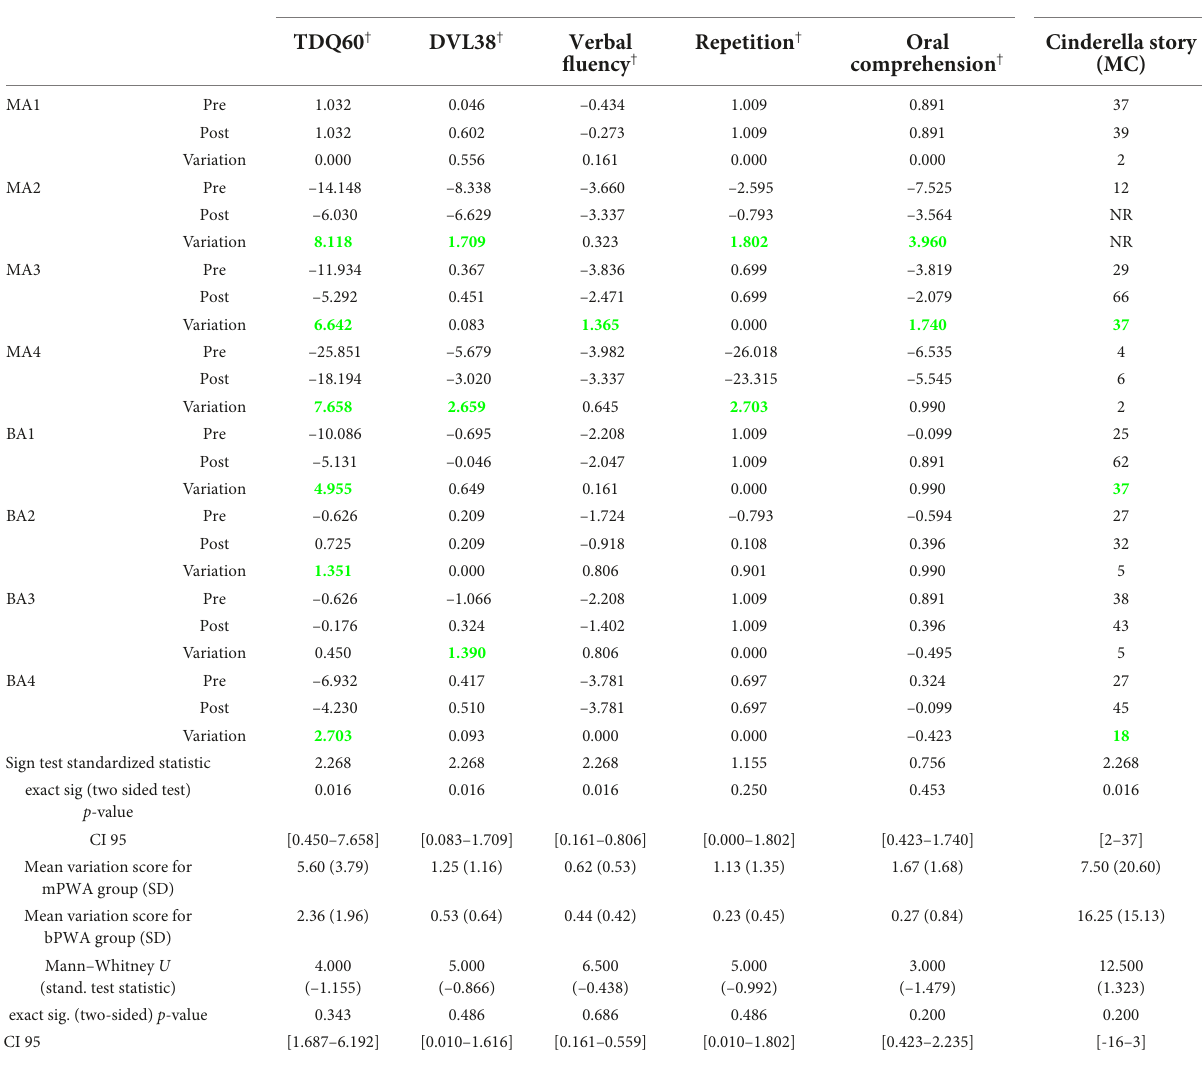
TABLE 4 Pre-therapy, post-therapy and variation of z -scores for all participants, exact sign test results testing the statistical difference between pre- and post-therapy for within-level generalization (TDQ60) and across-level generalization (DVL38, Verbal fluency, Repetition,